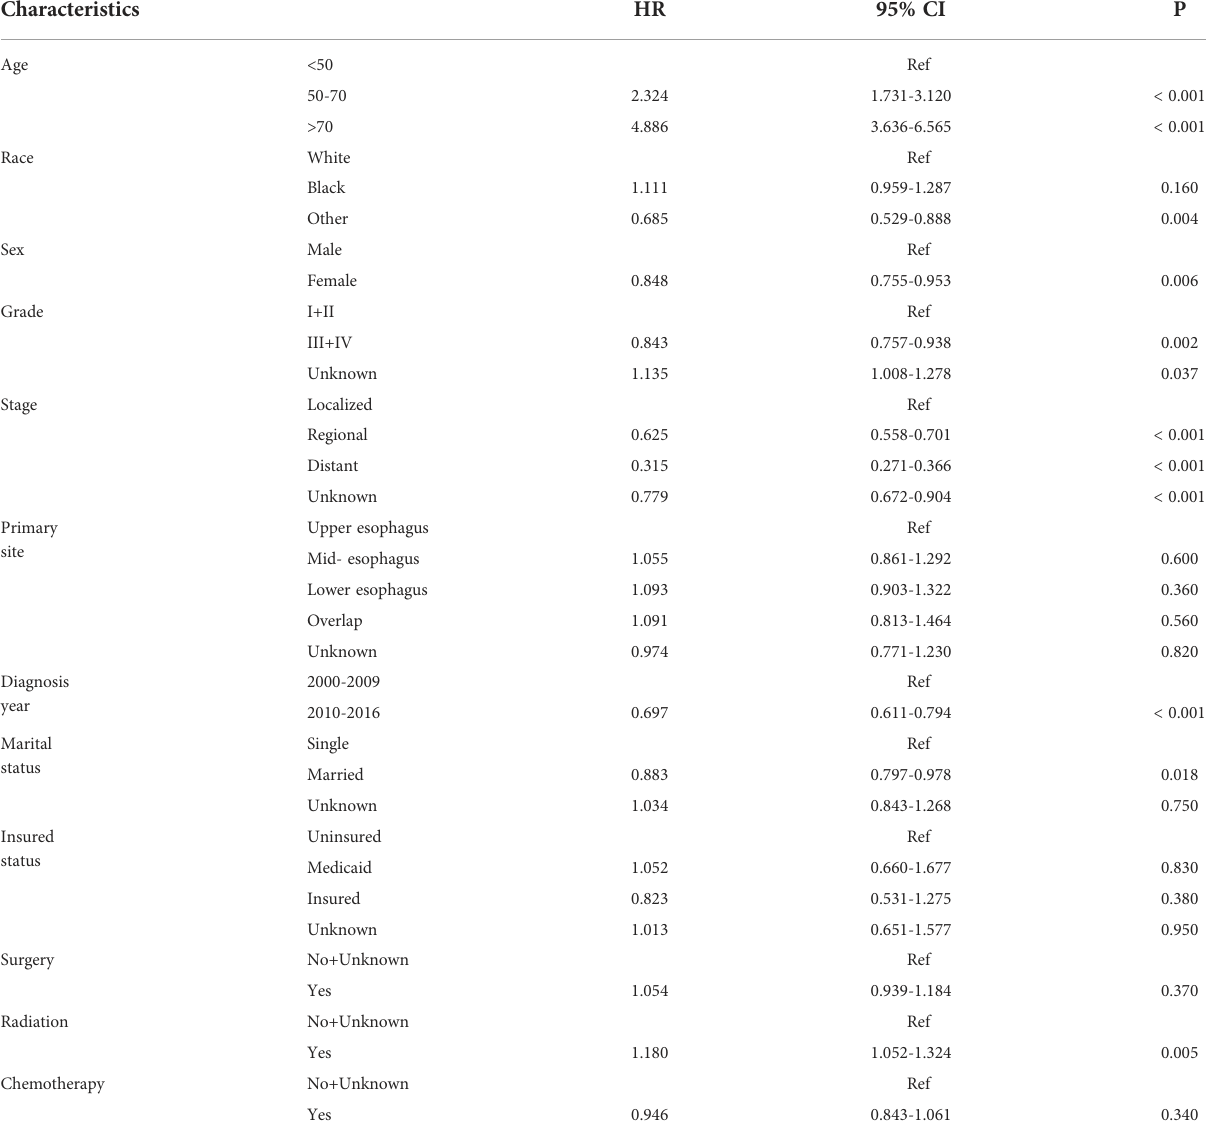
TABLE 3 Multivariate competing risk analysis for predictors of CVD related death in EC patients.